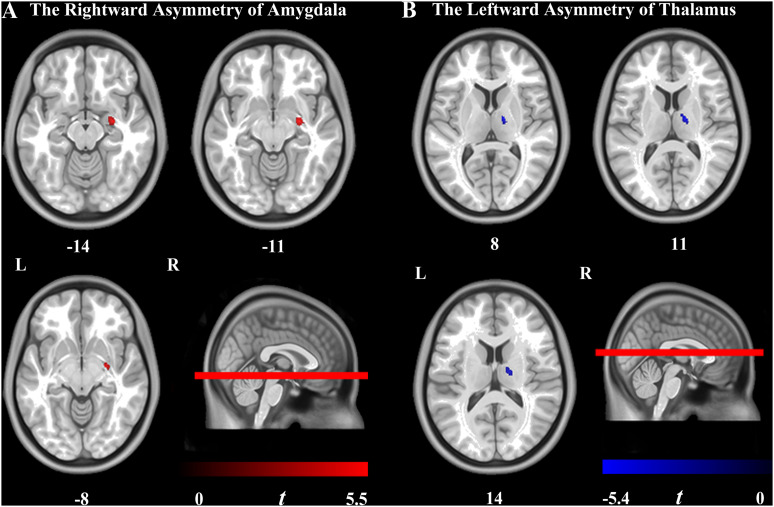
Brain regions showing the significant hemispheric asymmetry of VBM. (A) Rightward lateralization was found in the amygdala in the Alzheimer’s disease (AD) group. (B) Leftward lateralization was found in the thalamus in the AD group. Cluster-level familywise error rate-corrected p < 0.05 (uncorrected voxel-level p < 0.001; cluster size > 30 voxels) was utilized. The color bar indicates the t-value. L, left hemisphere; R, right hemisphere.